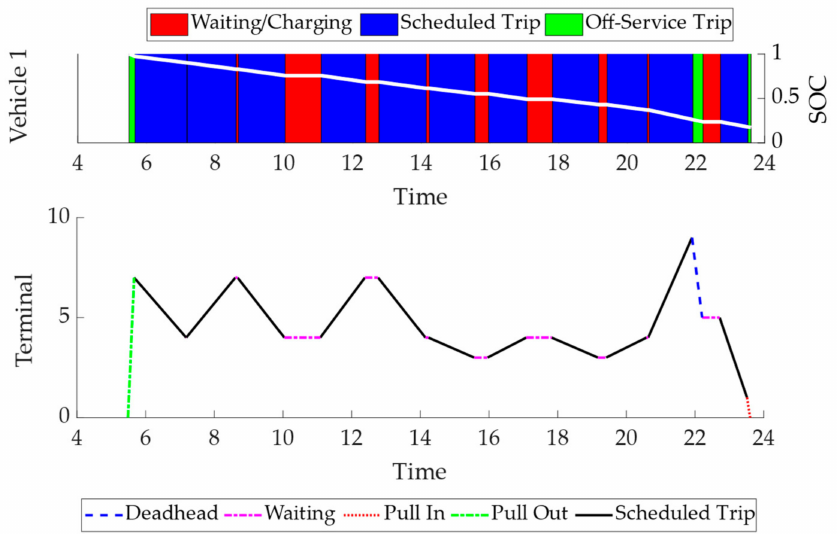
Figure 7. Showing the vehicle schedule and the state of charge (top), and the location and trips assigned to the vehicle during the day